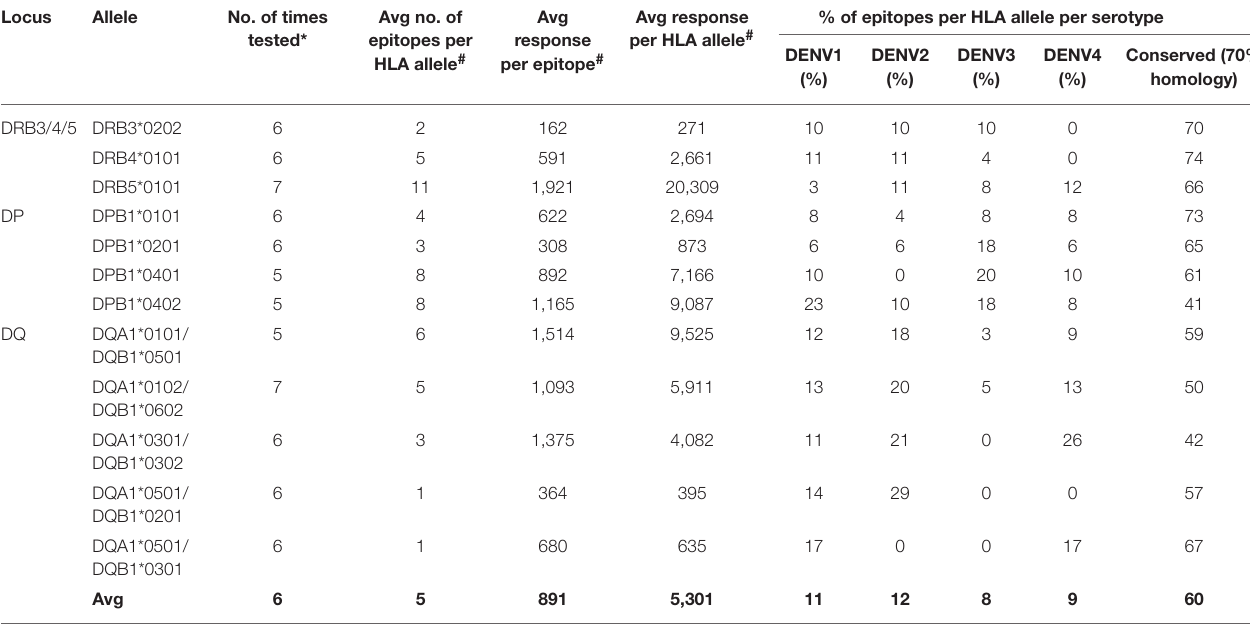
TABLE 1 | Characteristics of DENV-specific responses in DRB3/4/5, DP, and DQ loci. Locus Allele No. of times